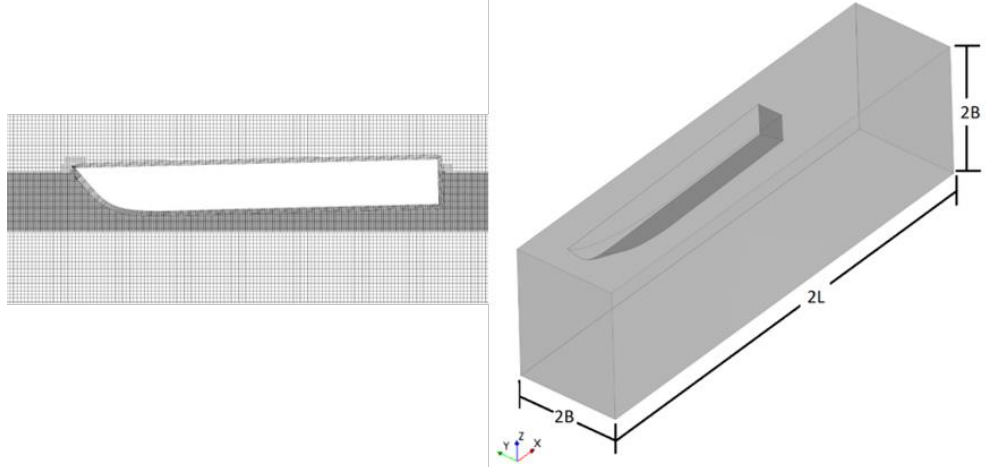
Figure 5. The overset region mesh along the hull centerplane (left) and dimensions of this region (right).